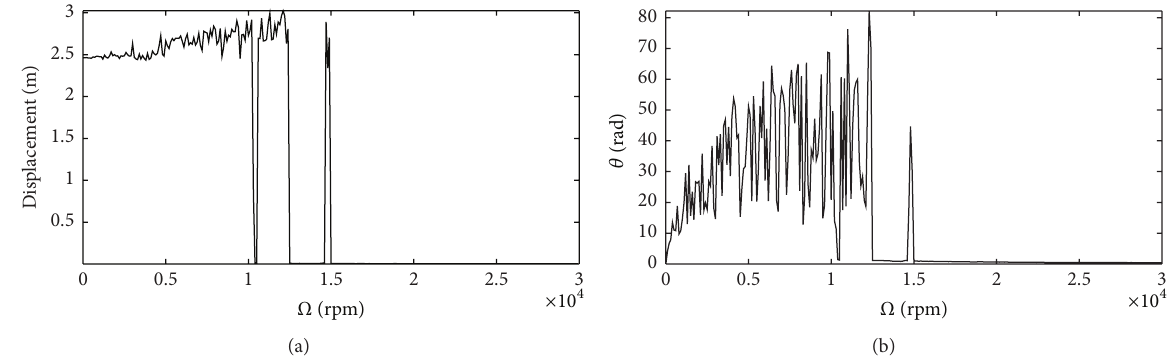
Figure 5: Rotational speed response curves: tip response of beam (a); gyro response (b) for 𝑘 = 𝐼 𝑜 𝜔 2 𝑛 /2 = 6.4 Nm / rad with the base excitation of 𝑧 = 0.05 cos (𝜔 𝑛 𝑡) .